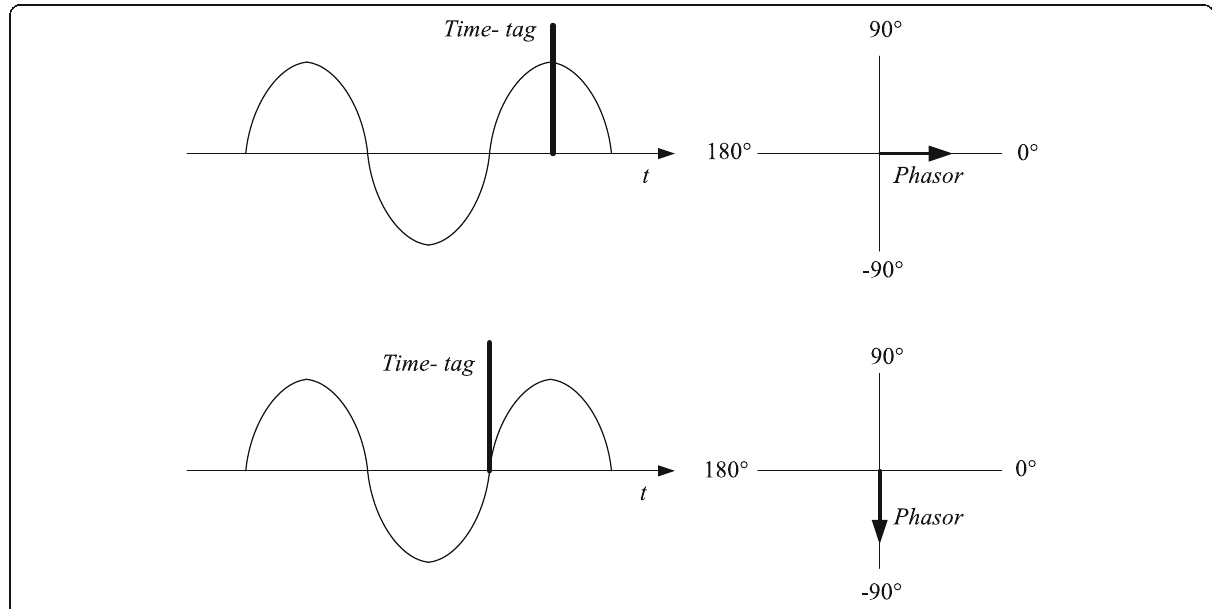
Fig. 1 Definition of synchronous phasor and the angular